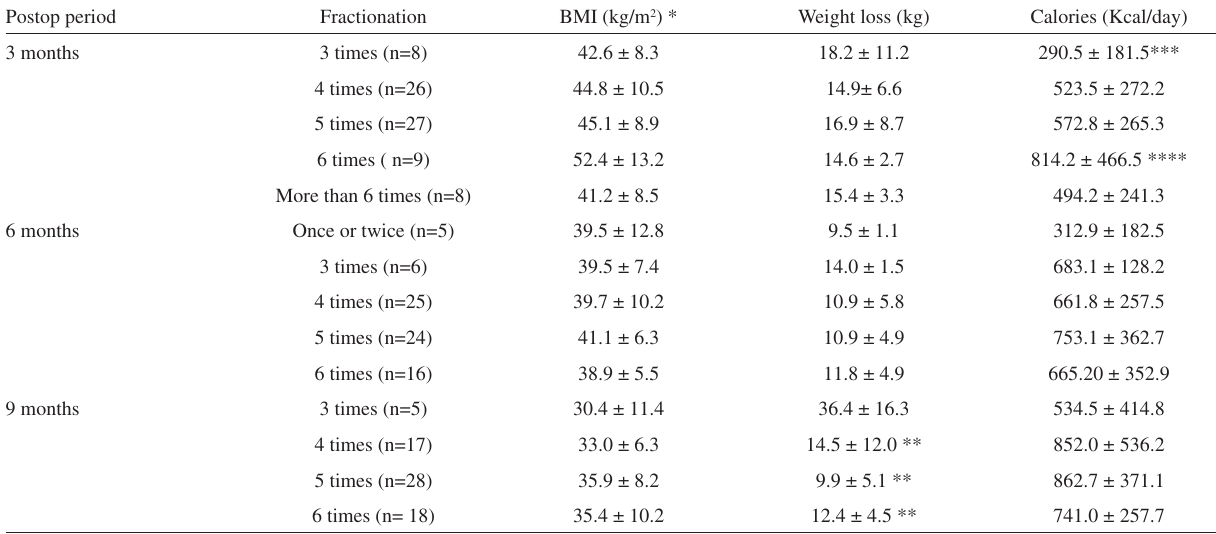
Table 3 - Nutritional course and diet